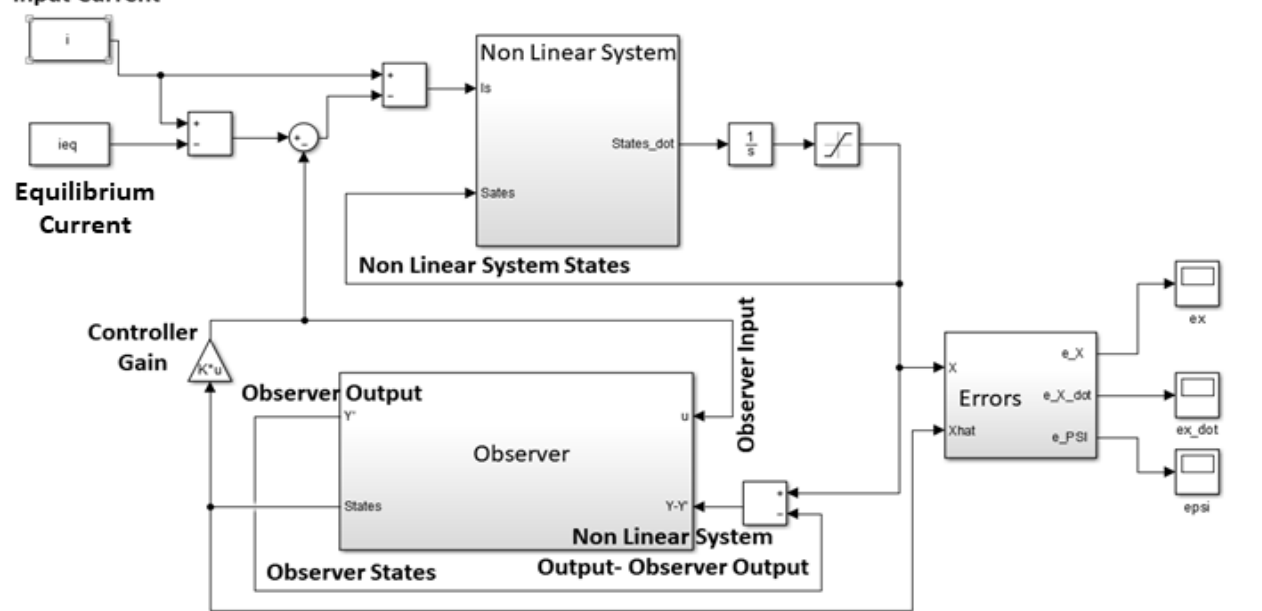
Figure 13. Simulink implementation of the nonlinear system, controller and observer.